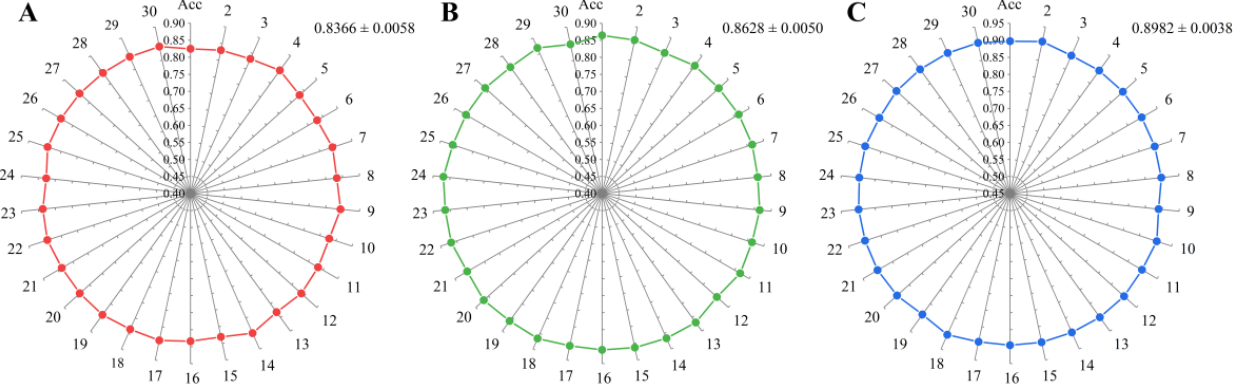
Figure 7. Thirty random sampling prediction experiments on plants of greater interest: ( A ) accuracy of each experiment on the Arabidopsis thaliana dataset; ( B ) accuracy of each experiment on the Oryza sativa dataset; ( C) accuracy of each experiment on the Solanum lycopersicum dataset.